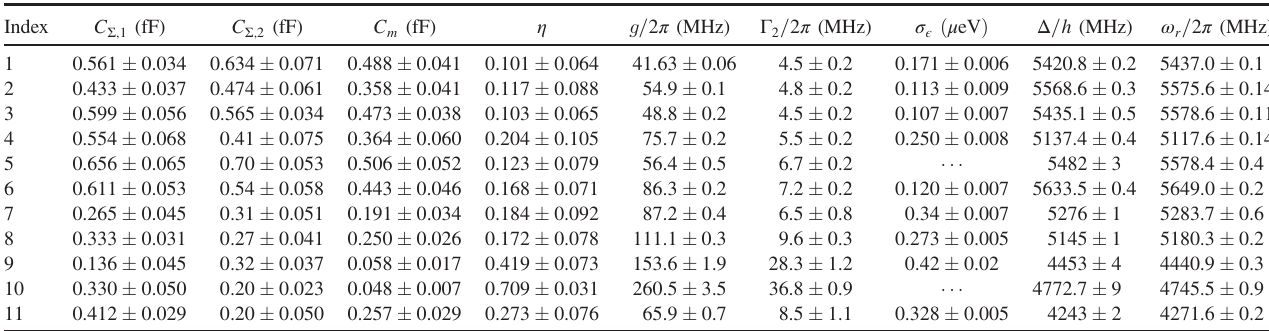
TABLE I. Extracted parameters for the 11 DQD configurations presented in Fig. 4 in Sec. III in the main